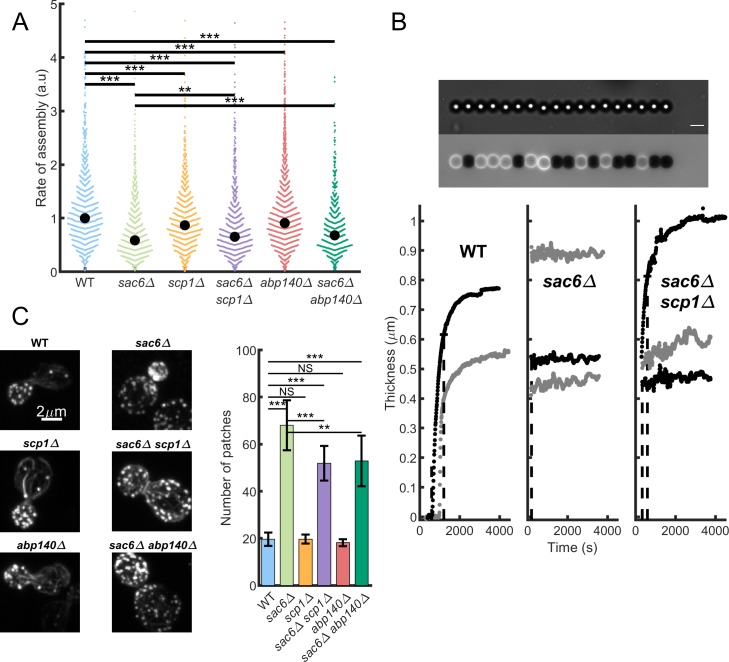
Dynamics of actin assembly.The underlying data can be found within S2 Data. (A) Net rate of actin patch assembly in cells. The rates are obtained from the curves of the fluorescence intensity as a function of time during the phase of patch assembly for all strains used in this study. Each colored dot is a measured patch. Black dot is the median. (B) Dynamics of reconstituted actin patch assembly. Growth of actin networks from protein extracts at the surface of magnetic beads. Top: Chain of magnetic beads in the bright field (top) and fluorescence (bottom) channels. On the fluorescence image, actin shells grown around magnetic beads (4.5 μm diameter) are visible in light gray, whereas black beads are nonactivated beads grafted with BSA. The image in bright field is focused below the equatorial plane of the beads to obtain nanometer resolution on the position of the center of the bead. Scale bar is 5 μm. Bottom: Evolution of the thickness of the shell with time for WT, sac6Δ, and sac6Δ scp1Δ protein extracts. For each strain, a few curves have been represented (gray and black). (C) Number of actin patches for the different strains. Left, typical images used to count the number of patches per cell. Such images are the result of the z-stack projection of the maximum intensities. Actin has been labeled by phalloidin–Alexa568. Right, average number of actin patches in the different strains. Error bars are standard errors. Abp140, actin-binding protein 140; a.u., arbitrary unit; BSA, bovine serum albumin; NS, not significant; Sac6, yeast homolog of fimbrin; Scp1, yeast homolog of calponin; WT, wild type.